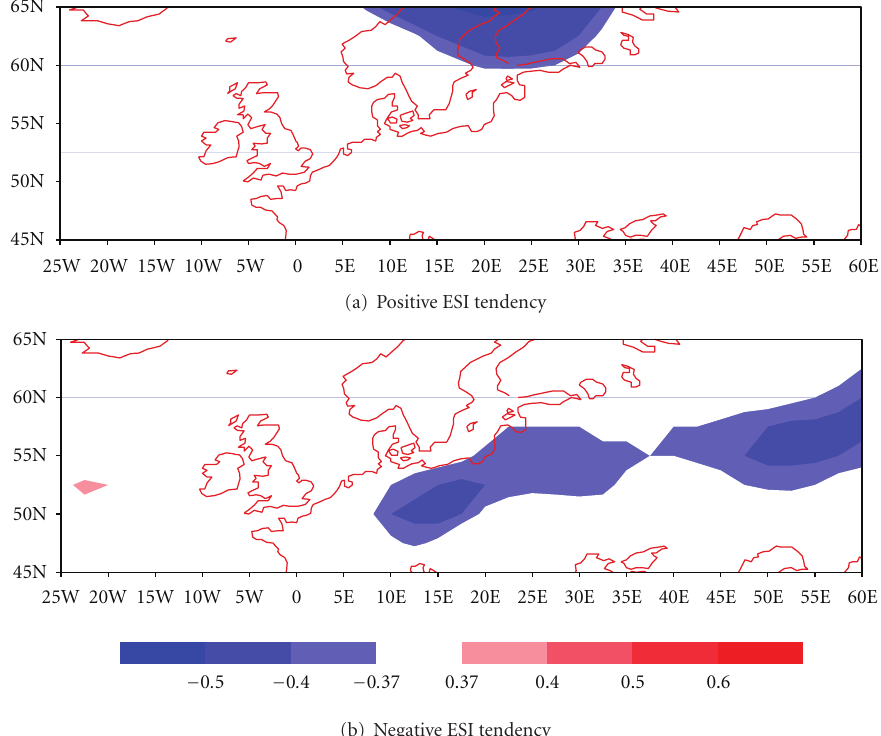
Figure 1: The correlation coe ffi cients between ESI tendency and Winter temperature anomaly over Europe (45 ◦ –65 ◦ N, 25 ◦ W–60 ◦ E) during (a) positive (29 years) and (b) negative (28 years) ESI